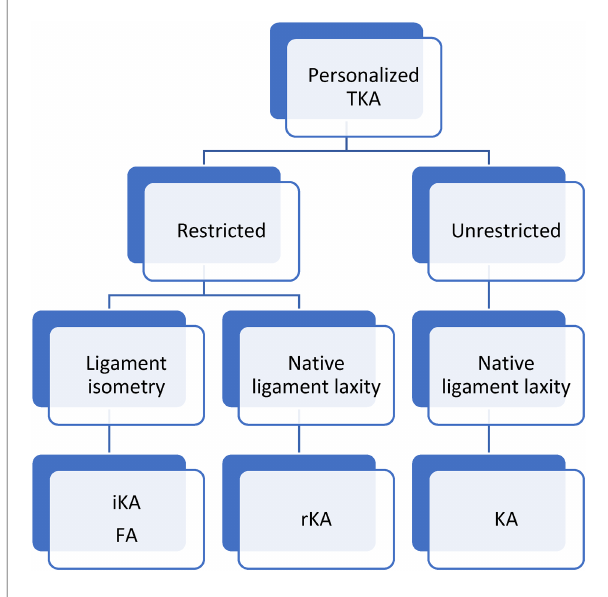
FIGURE 1 Diagram of the most common personalized total knee replacement surgical techniques. KA, kinematic alignment; iKA, inverse kinematic alignment; FA, fonctional alignment; rKA, restricted kinematic